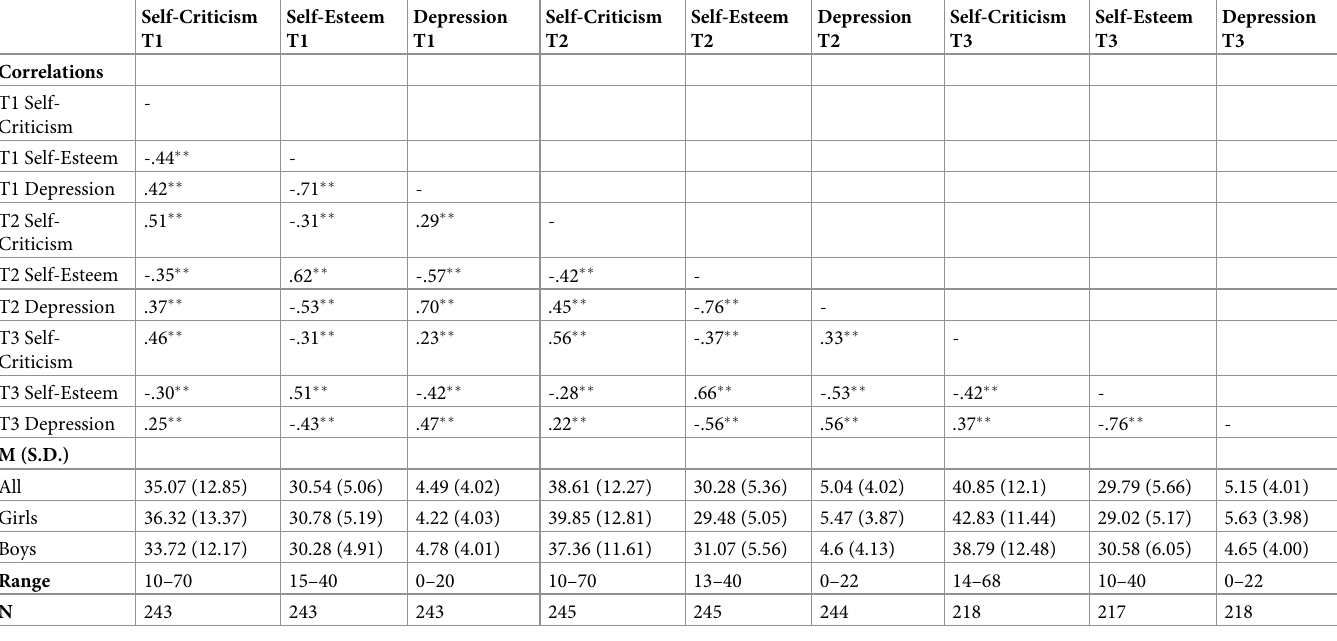
Table 2. Descriptive statistics and Pearson’s